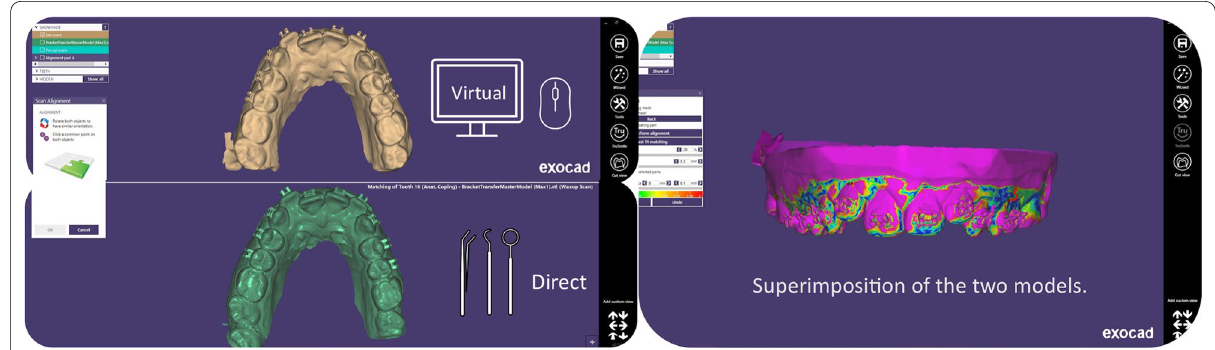
Fig. 5 Superimposition of the models on the Exocad ™